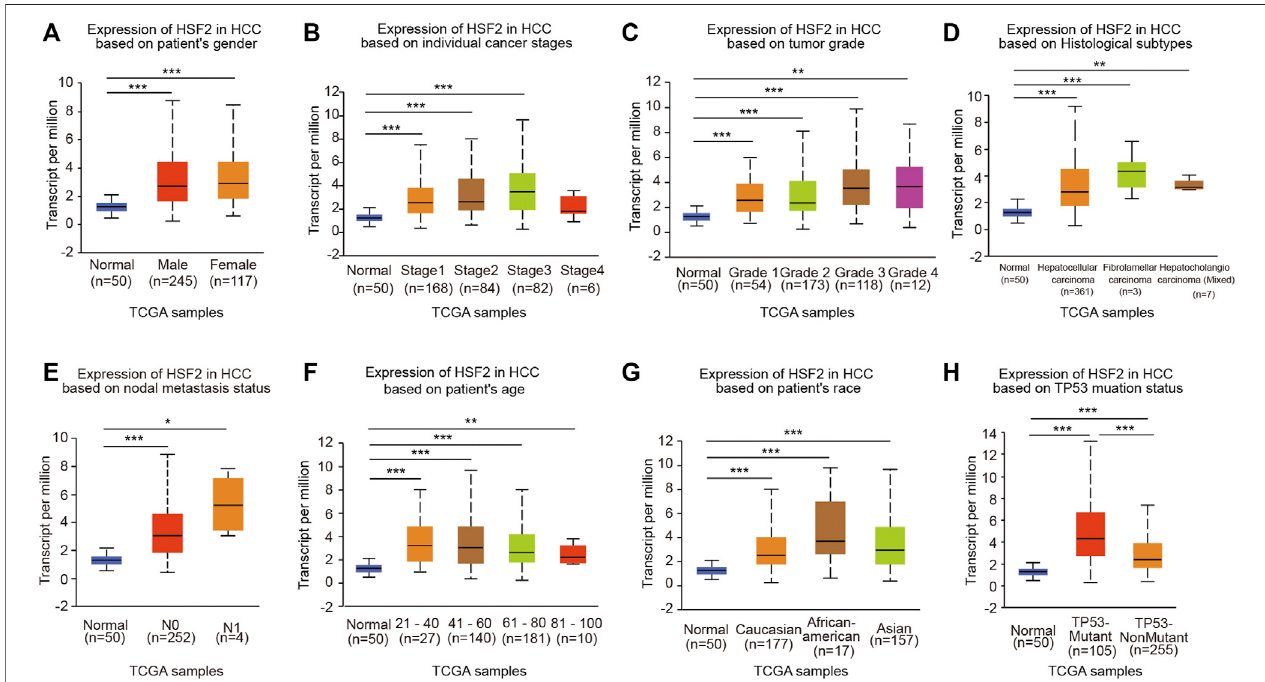
FIGURE 2 | HSF2 expression among different groups of patients strati fi ed based on clinical parameters. The analyses of HSF2 expression based on (A) sex (female, n (cid:1) 117; male, n (cid:1) 245), (B) cancer stage (normal individuals, n (cid:1) 50; stage 1, n (cid:1) 168; stage 2, n (cid:1) 84; stage 3, n (cid:1) 82; stage 4, n (cid:1) 6), (C) tumor grade (normal individuals, n (cid:1) 50;grade1, n (cid:1) 54;grade2, n (cid:1) 173;grade3, n (cid:1) 118;grade4, n (cid:1) 14), (D) histologicalsubtype(normalindividuals, n (cid:1) 50;hepatocellularcarcinoma, n (cid:1) 361; fi brolamellar carcinoma, n (cid:1) 3; hepatocholangiocarcinoma, n (cid:1) 7), (E) metastasis (normal individuals, n (cid:1) 50; N0, n (cid:1) 252; N1, n (cid:1) 4), (F) age (normal individuals, n (cid:1) 50;21 – 40 years, n (cid:1) 27;41 – 60 years, n (cid:1) 140;61 – 80 years, n (cid:1) 181;and81 – 100 years, n (cid:1) 10), (G) race(normalindividuals, n (cid:1) 50;Caucasian, n (cid:1) 177; African-American, n (cid:1) 17;Asian, n (cid:1) 157),and (H) TP53mutationstatus(normalindividuals, n (cid:1) 50;TP53-nonmutant, n (cid:1) 255;TP53-mutant, n (cid:1) 105)usingTCGA-HCC dataset are shown. N0, no regional lymph node metastasis; N1, metastases in 1 – 3 axillary lymph nodes. * p < 0.05, ** p < 0.01, *** p <